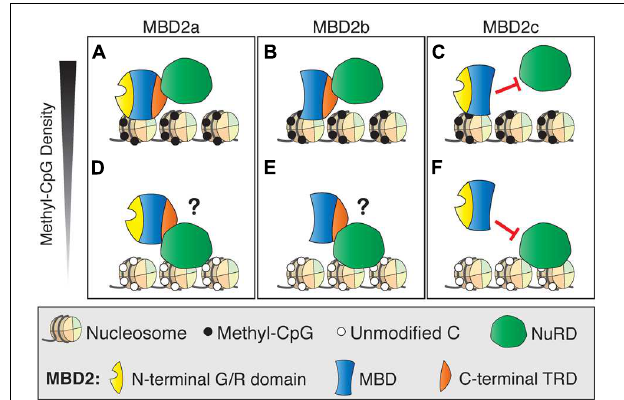
FIGURE 5 | Different DNA binding and NuRD interactions of MBD2 isoforms. (A) MBD2a binds to methyl-CpG dense sites with the NuRD complex. (B) At unmethylated sites, MBD2 recruitment to DNA is dependent on interactions with NuRD through the C-terminal TRD. (C) Similarly to MBD2a, MBD2b binds to methyl-CpG dense sites with NuRD and may be recruited to unmethylated sites via interaction with NuRD (D) . MBD2c lacks the C-terminal TRD and does not interact with NuRD. Therefore, MBD2c may bind methylated sites without NuRD (E) and, in this model, would not be recruited to unmethylated sites by NuRD (F)